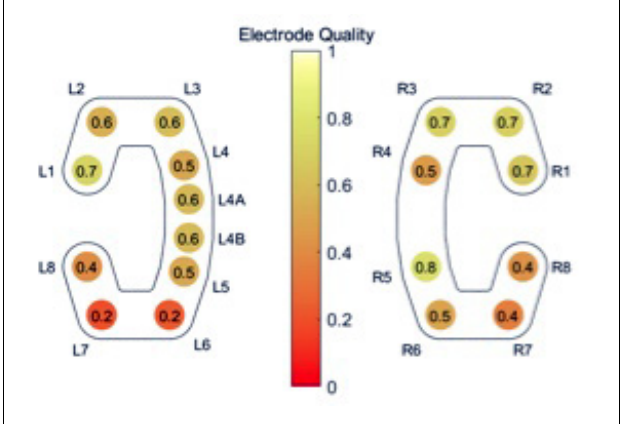
FIGURE 2 | Overview of the reliability of each electrode, measured as the fraction of total recording time available after electrode